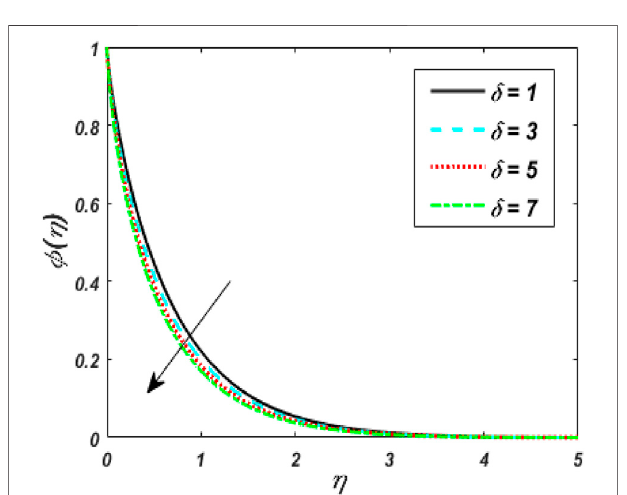
FIGURE 13 | δ against ϕ ( η ) .